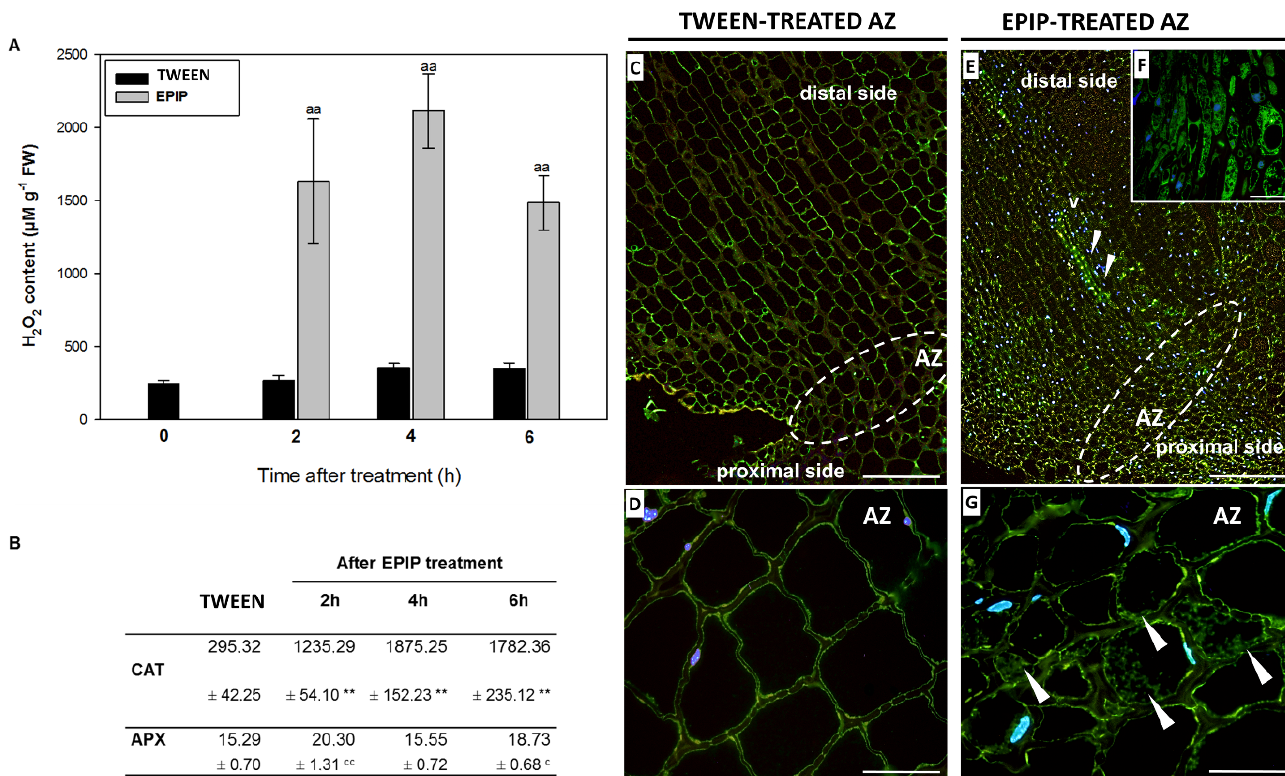
Figure 5. Exogenous EPIP stimulates the hydrogen peroxide (H 2 O 2 ) formation ( A ), accelerates the enzymatic activity of catalase (CAT) and ascorbate peroxidase (APX) ( B ), and changes CAT localization ( C – G ) in floral abscission zone (AZ) of yellow lupine. The EPIP peptide (100 µ M in 0,05% Tween 20) was applied directly to inactive AZ. The AZ samples were excised after 2 h, 4 h, and 6 h of treatment. The values for each isoform were normalized to the inactive AZ treated 0.05% Tween 20 solution. Data are presented as averages SE. For H 2 O 2 , significant differences for EPIP treated plants ± in comparison to Tween-treated are indicated as aa p < 0.01; for CAT, significant differences for EPIP treated plants in comparison to Tween-treated are indicated as ** p < 0.01, for APX significant differences for EPIP treated plants in comparison to control are indicated as c p < 0.05, cc p < 0.01. The localization of CAT was examined 6 h after the EPIP application. The green signal marked by arrows corresponds to CAT presence, while blue fluorescence to DAPI-stained nuclei. White lines were used to mark AZ regions. Bars—100 µ m ( A , E ), 40 µ m ( D , G ), 20 µ m ( F ).